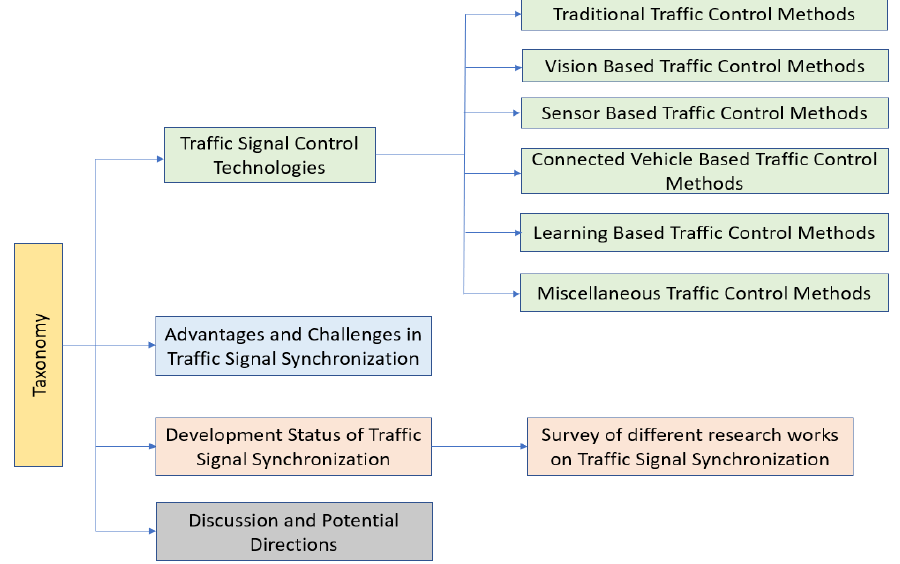
Figure 2. Taxonomy of the